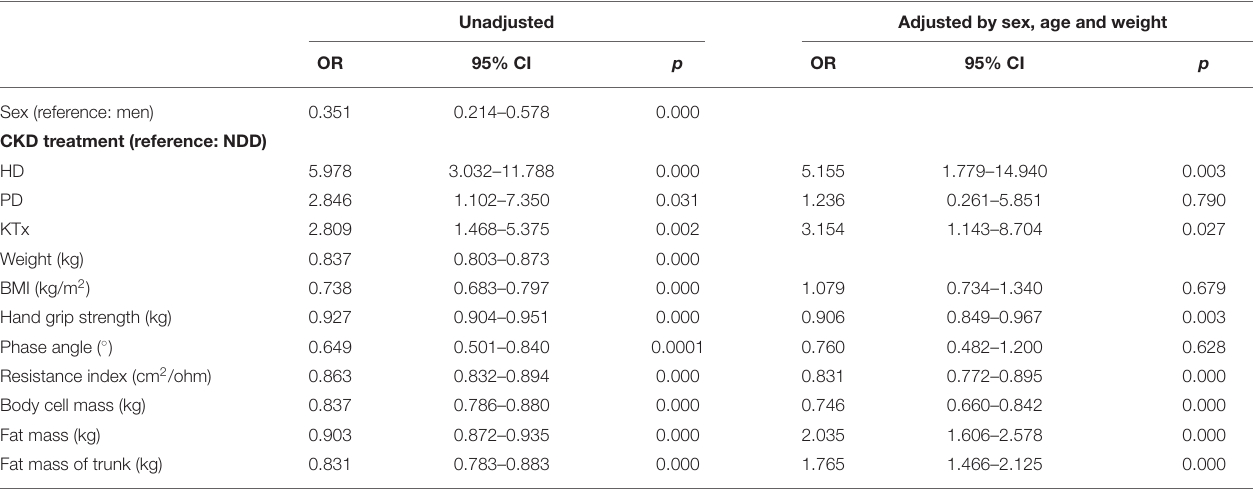
TABLE 2 | Odds Ratio of low muscle mass diagnosis in total sample ( n =